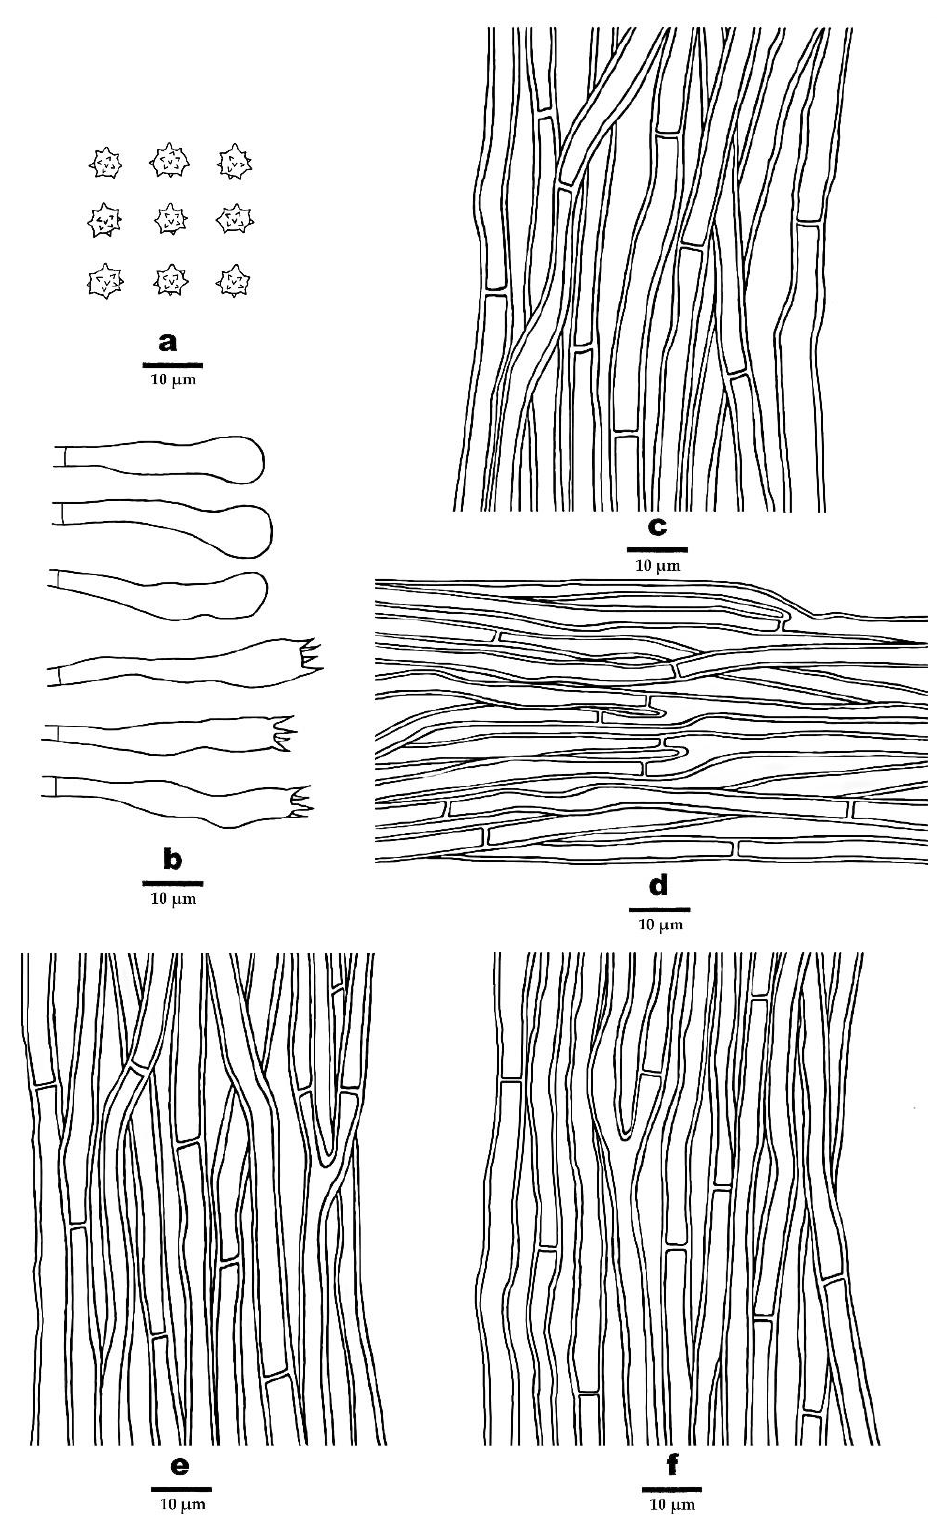
Figure 8. Microscopic structures of P. subgriseofuscus (drawn from the holotype). ( a ) Basidiospores, ( b ) Basidia and basidioles, ( c ) Hyphae from context, ( d ) Hyphae from spines, ( e ) Hyphae from inner layer of stipe, and ( f ) Hyphae from surface layer of stipe.